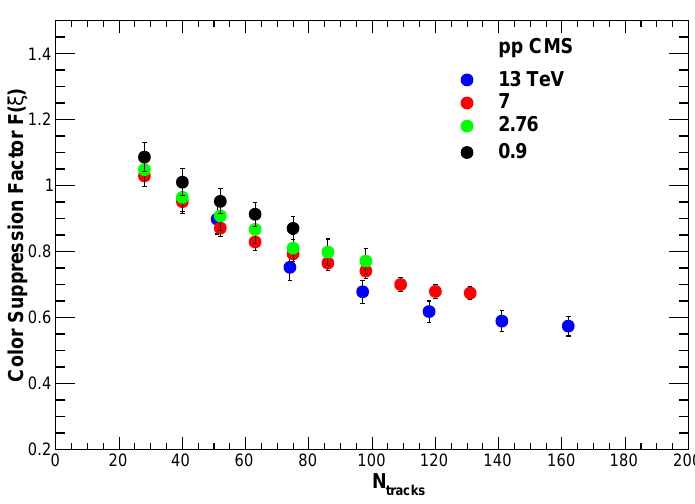
Figure 5. Color Suppression Factor F ( ξ ) in pp collisions vs. N tracks